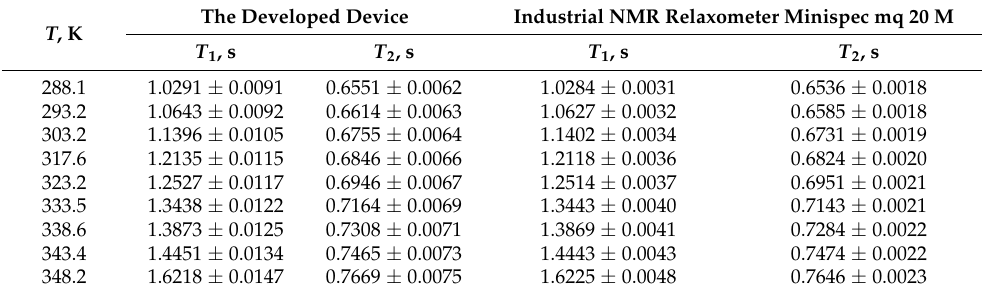
Table 3. Results of measuring the relaxation times T 1 and T 2 of an aqueous solution (H 2 O + H 3 BO 3 ) with plutonium nitride filling at different temperatures T with two